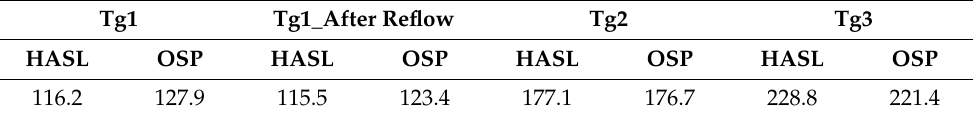
Table 4. Glass transition temperatures (expressed in Celsius) determined by